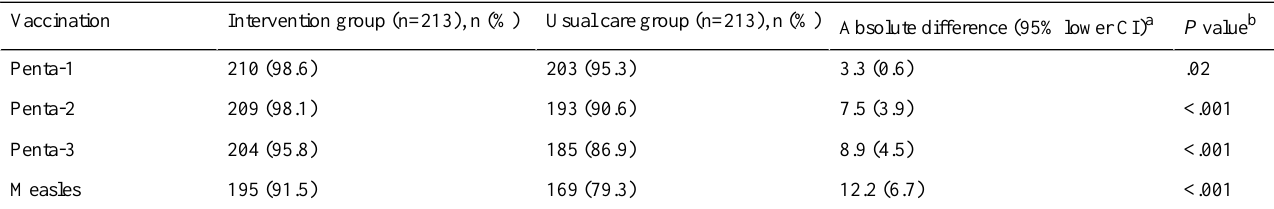
Table 3. Effect of mobile phone text message reminders on receipt of specific vaccines in Gondar city, northwest Ethiopia in 2020